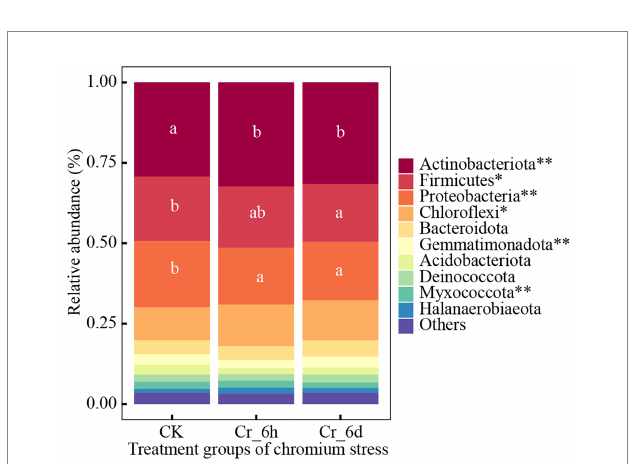
FIGURE 2 Phylum level bacterial community structures and differences among treatments in chromium-contaminated soils. Significance (P), * p ≤ 0.05, ** p ≤ 0.01, *** p ≤ 0.001; CK, control treatment; Cr_6h, Cr stress for 6 h; Cr_6d, Cr stress for 6 days. Different lowercase letters indicate significant differences between components ( p < 0.05). ‘Others’ represents the sum of the relative abundance of the remaining